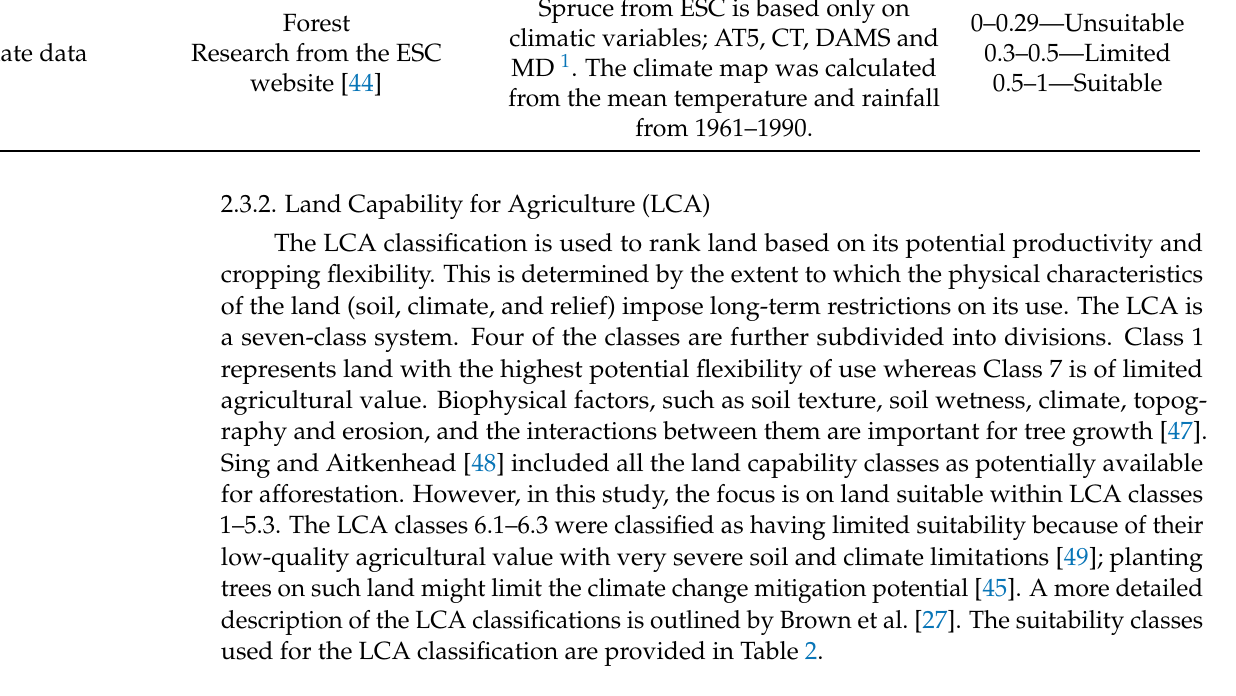
Table 2. Description of the LCA classification